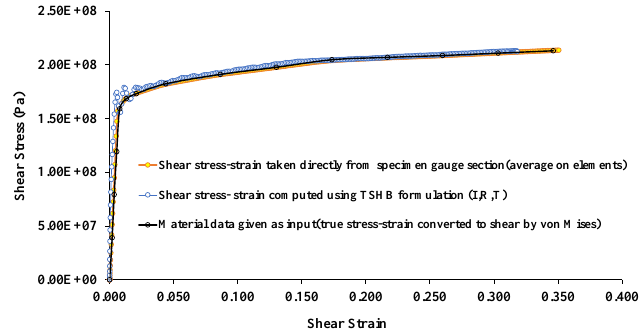
Shear Strain Fig. 10. Perfectly bonded case shear stress-strain comparison